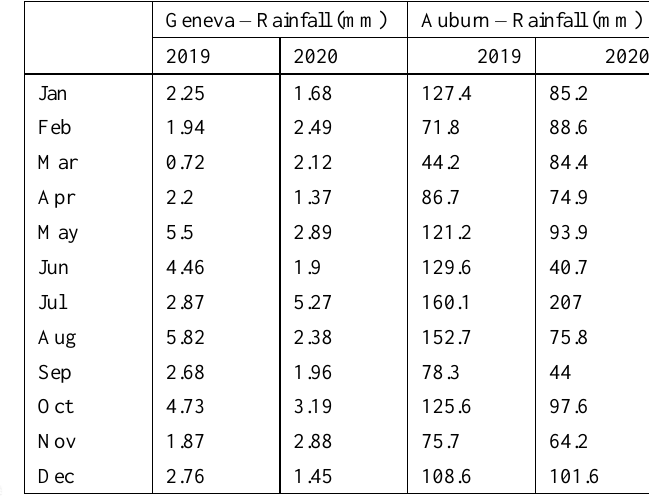
Geneva – Rainfall (mm) Auburn – Rainfall (mm)